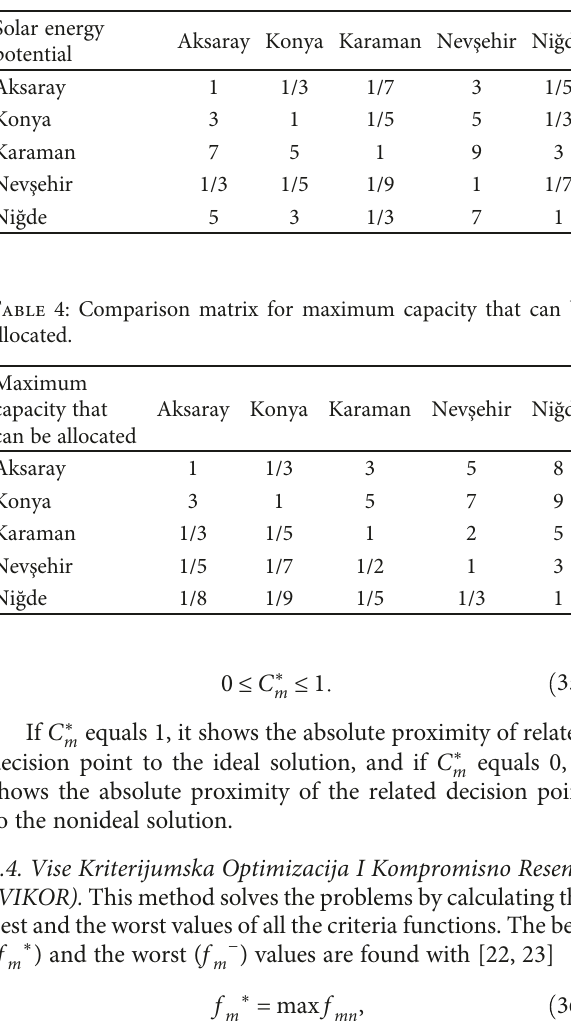
Table 5: Comparison matrix for surface slope.